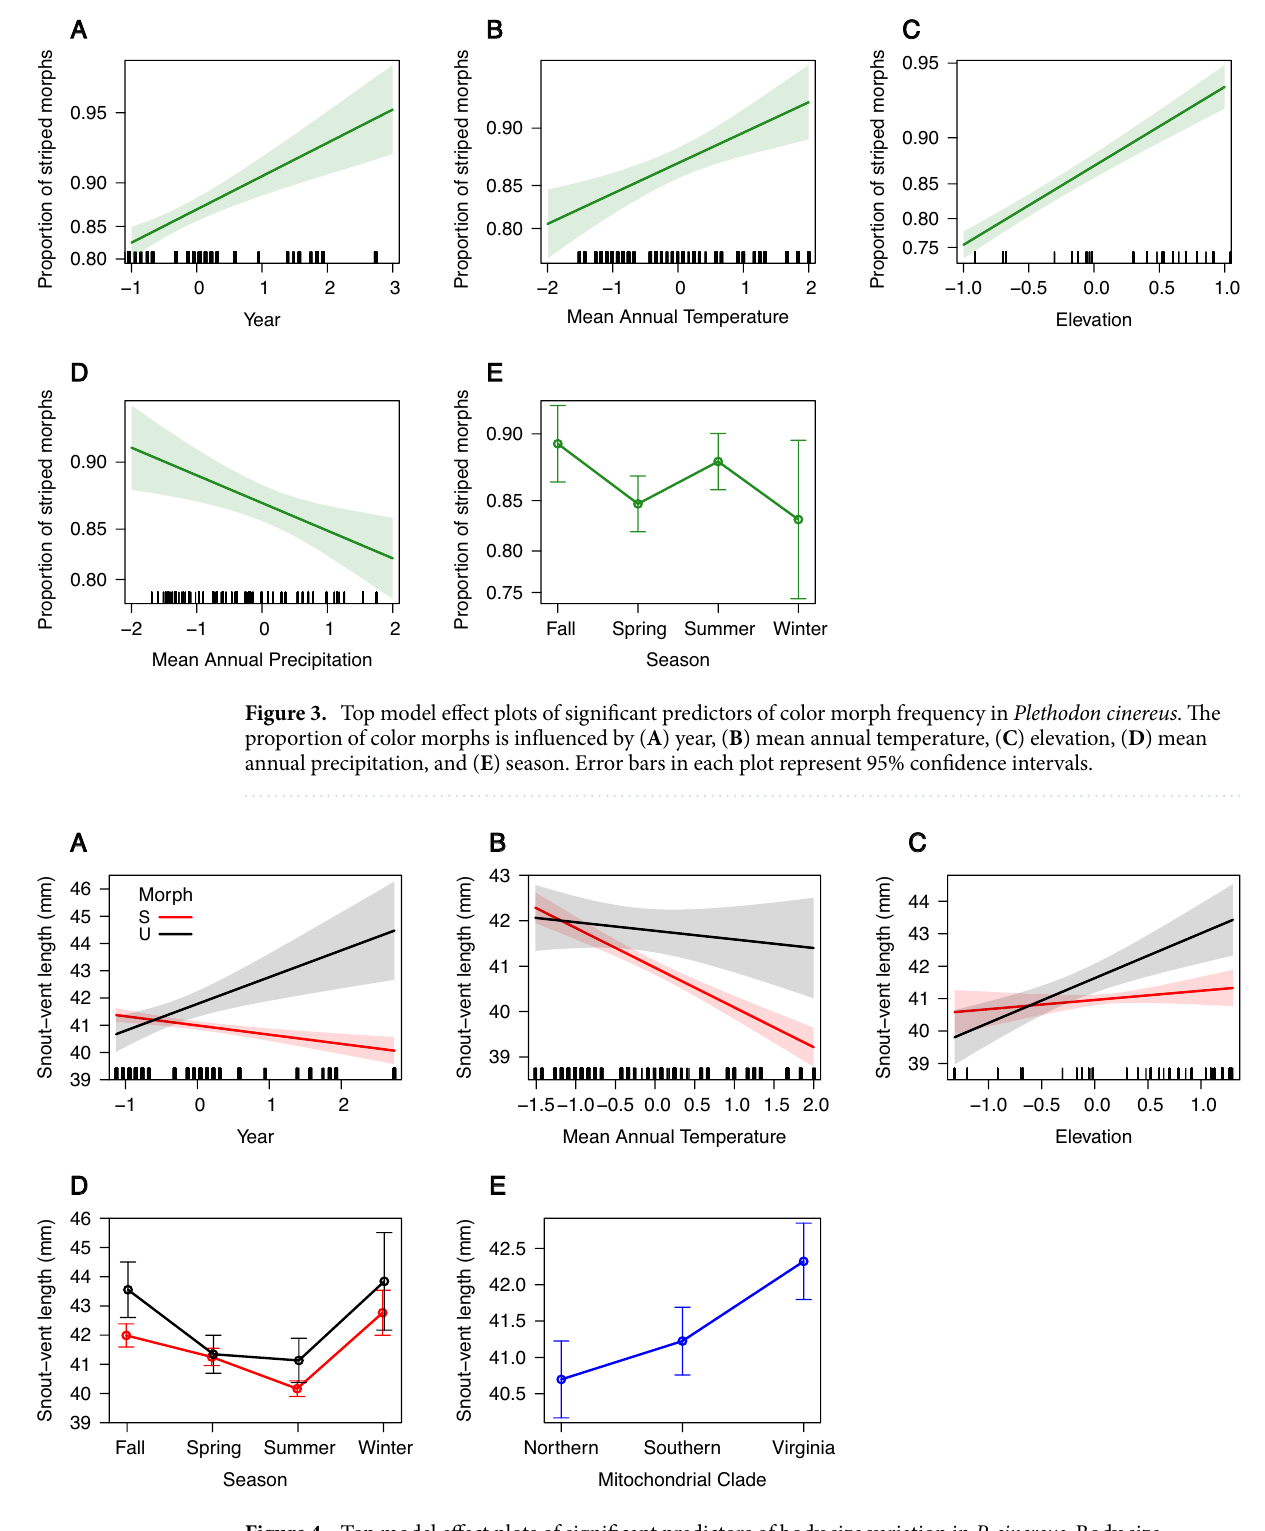
Figure 4. Top model effect plots of significant predictors of body size variation in P. cinereus . Body size (snout–vent length) is influenced by ( A ) the interaction between color morph and year, ( B ) the interaction between color morph and MAT, ( C ) the interaction between color morph and elevation, ( D ) the interaction between color morph and season, and ( E ) mitochondrial clade. Error bars in each plot represent 95% confidence